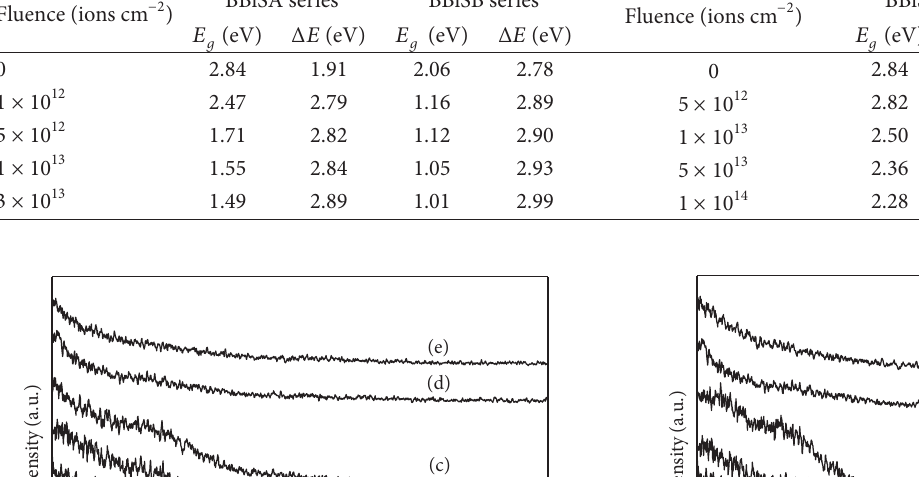
T 2: Showing the �uence ranges and the values of optical band gap and Urbach of samples of BBiSA and BBiSB series irradiated with Ag 14+ and Li ion. Ag 14+ ion irradiated Li 3+ ion irradiated Fluence (ions cm